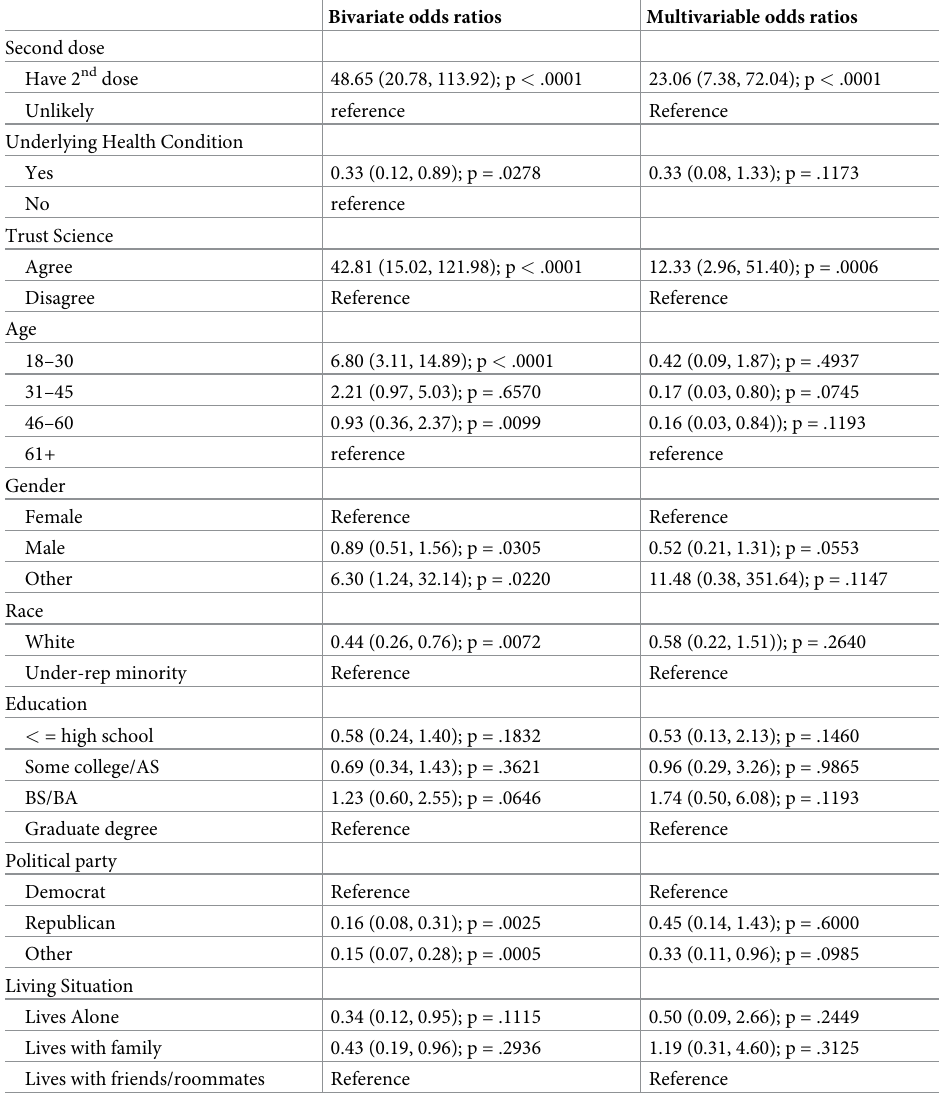
Table 3. Bivariate analysis for variables associated with perceived barriers to vaccination. Bivariate odds ratios Multivariable odds